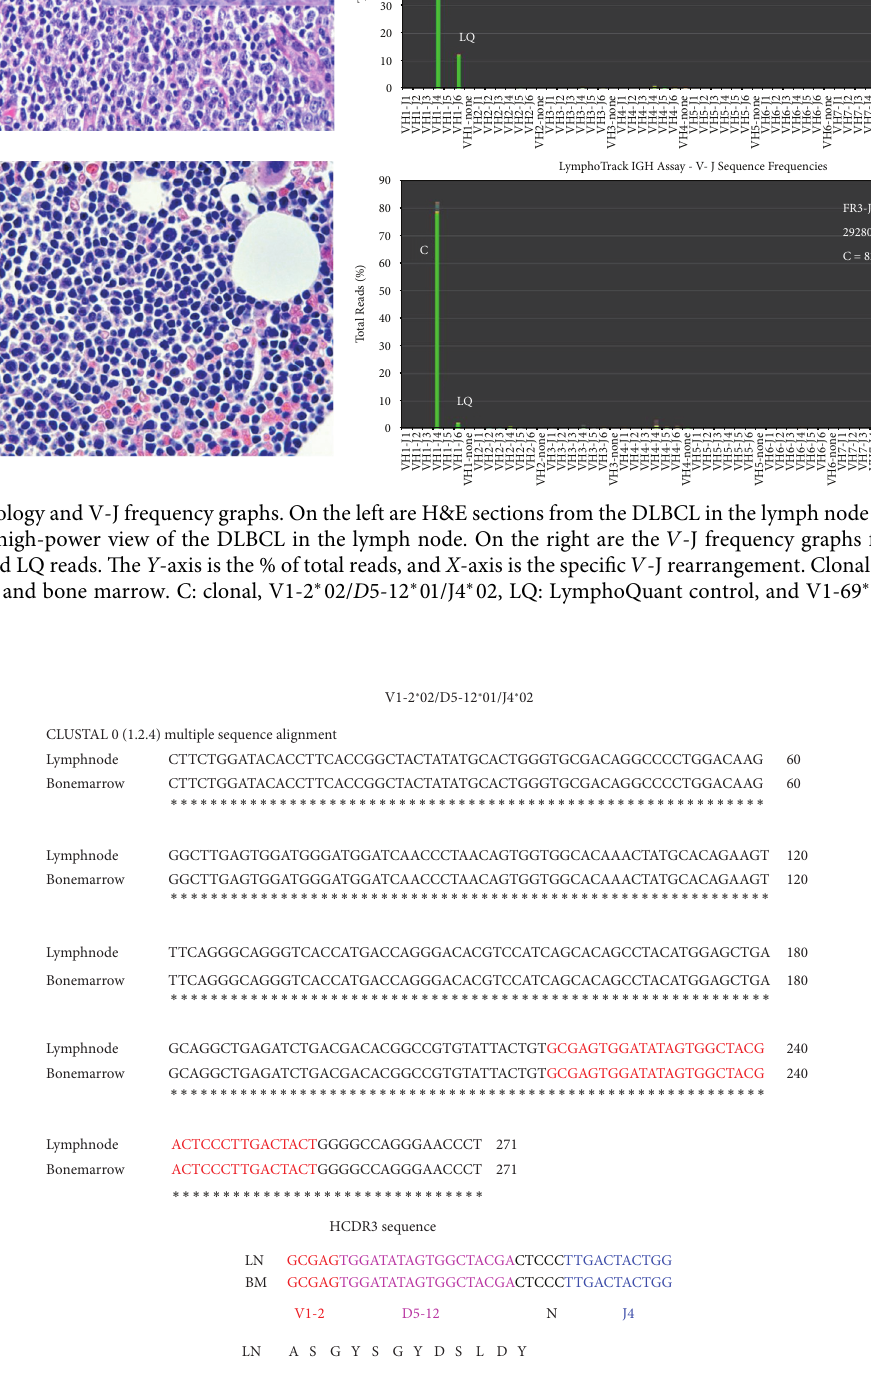
Figure 2: Alignment of the clonal sequence from lymph node and bone marrow. An identical clonal VDJ rearrangement is present in both specimens. The HCDR3 sequence is shown in red. The contribution of the V , D , and J segments to the HCDR3 sequence is shown (nucleotide,